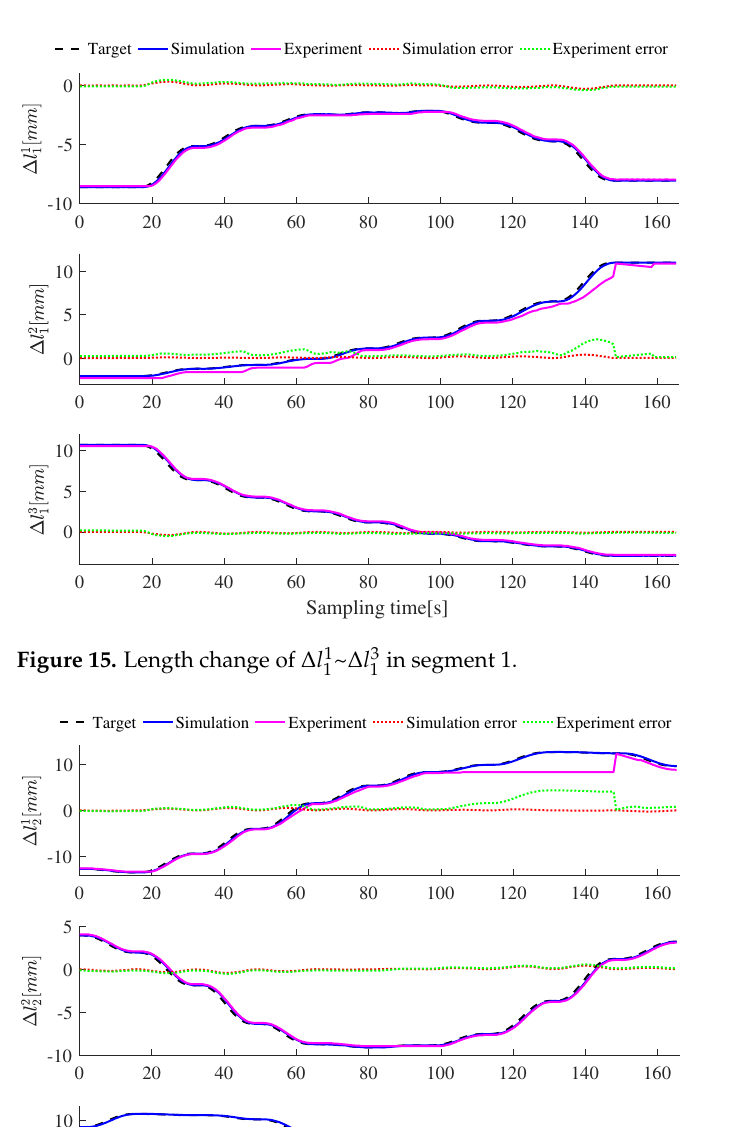
Figure 16. Length change of ∆ l 1